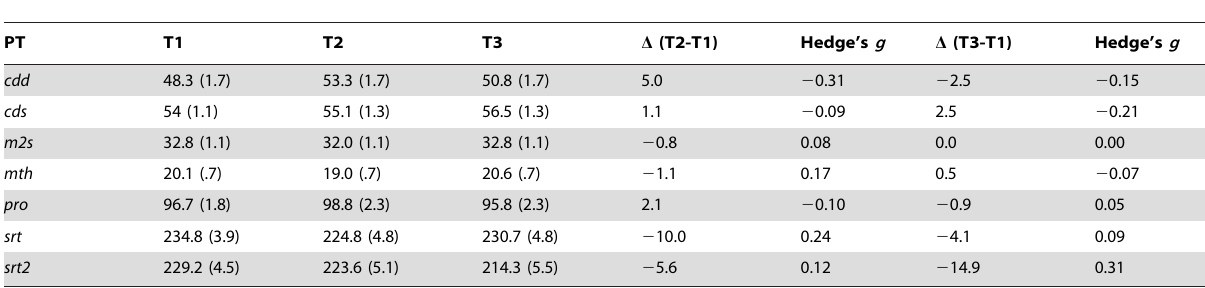
Table 4. Throughput Means (SE) for Non-Concussed Service Members.